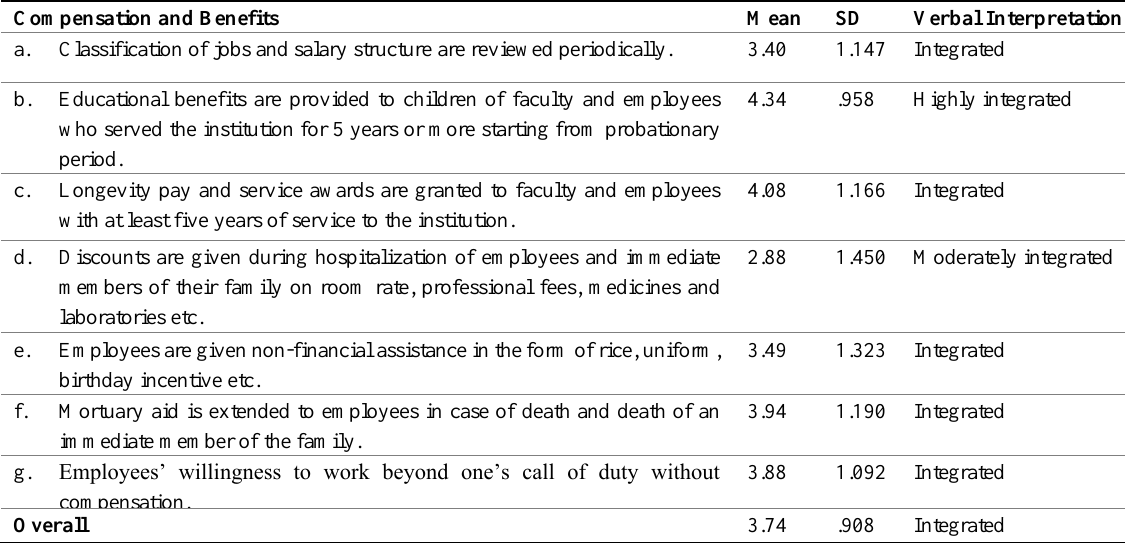
Table 9: Extent of Integration of Social Responsibility to Compensation and Benefits as Perceived by Respondents Compensation and Benefits Mean SD Verbal